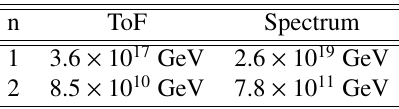
Table 2. Limits on Lorentz Invariance violation from the observations of the 2014 flare of Mrk 501. The constraints are expressed as 95% C.L. lower limits on E QG for the linear (n = 1) and quadratic cases (n = 2) in case of subluminal